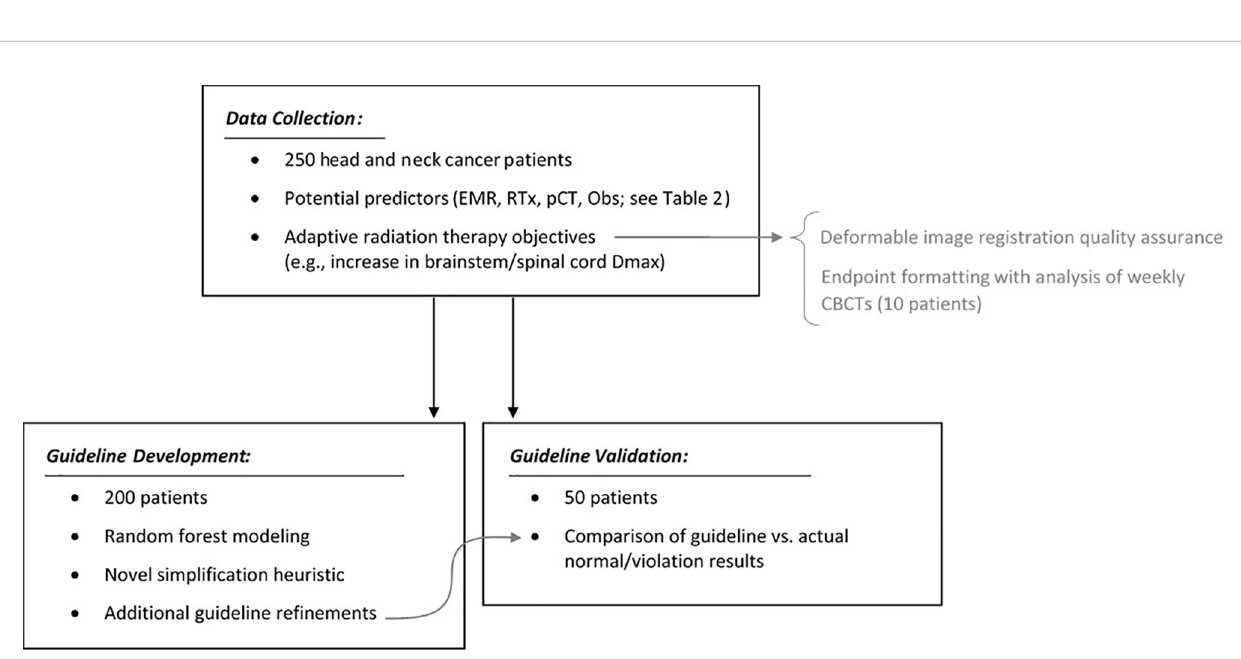
FIGURE 2 | Summary of the heuristic process used to convert RF model results into simple ART patient selection guidelines.